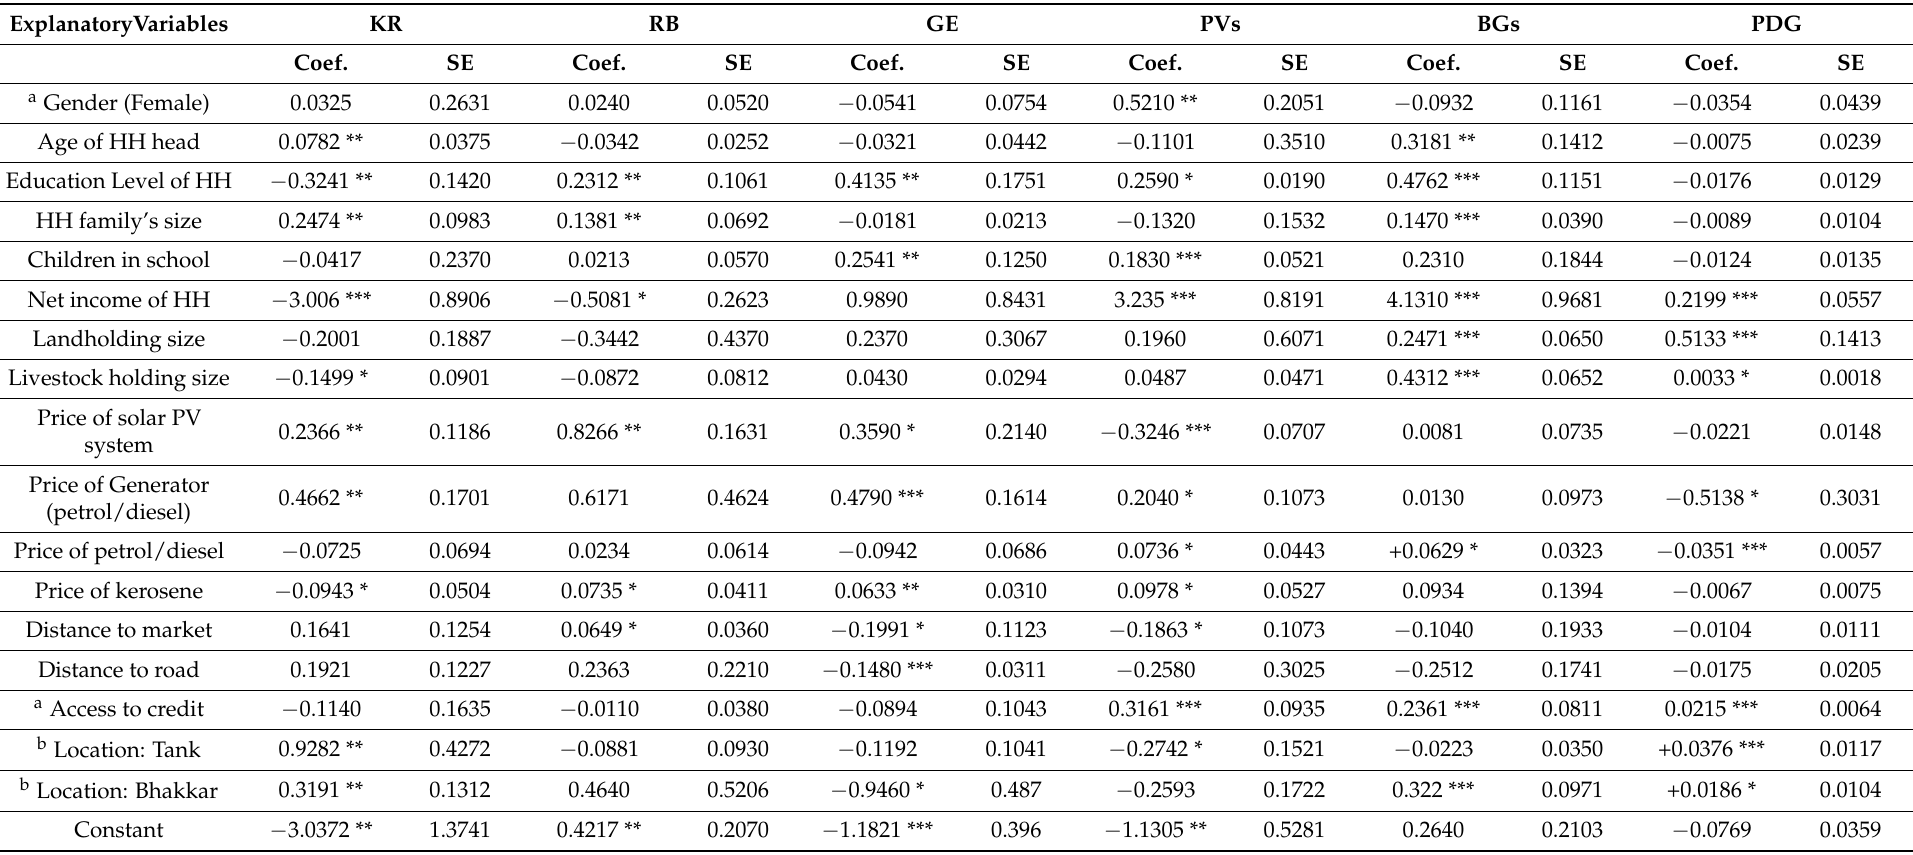
Table 7. Factors affecting households’ energy choices for lighting: MVP model